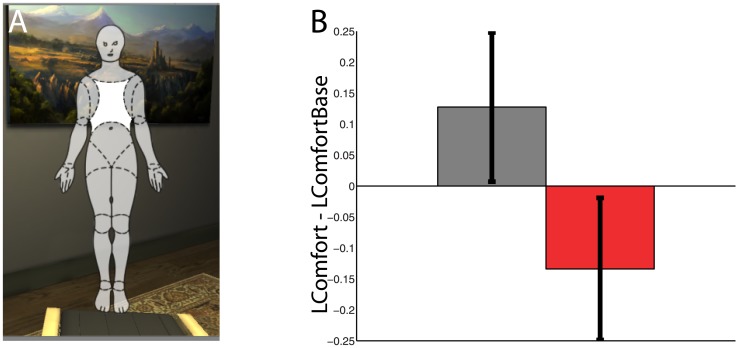
Assessment of Comfort (A) Frontal view of the body map used where each area of the body highlighted in turn and participants were asked to score their level of comfort for that body part on a 1–7 Likert scale. (B) Bar charts showing the means and standard errors of the Comfort—ComfortBaseline by Condition.